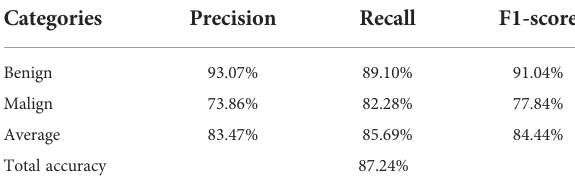
TABLE 7 Evaluation results of CAD on the unbalanced